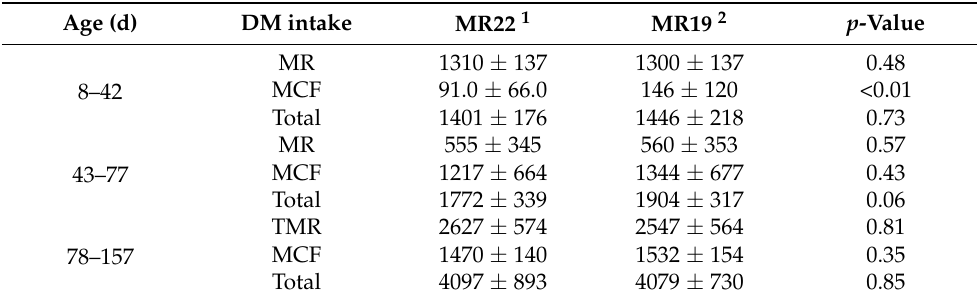
Table 3. Dry matter (DM) intake (g/d) differentiated according to experimental periods and feed sources given in g/animal/d (mean ±